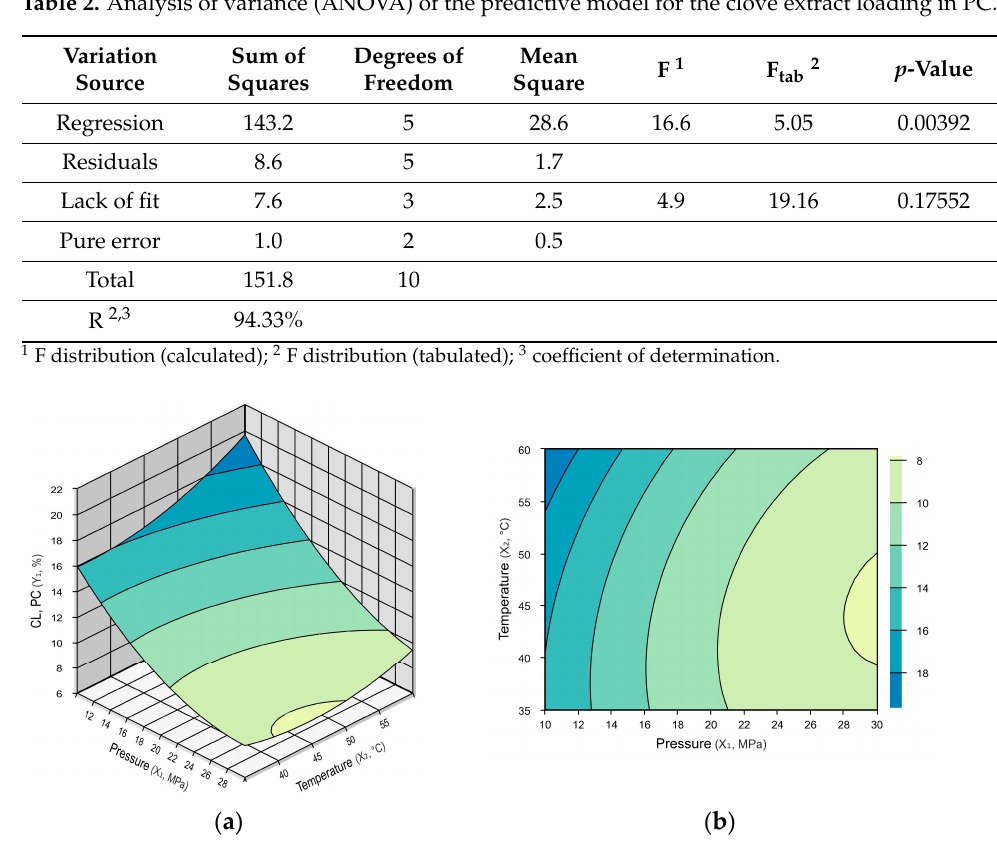
Figure 6. ( a ) Response surface and ( b ) contour plot for extract loading (CL%) of clove extract in PC as functions of pressure and temperature.